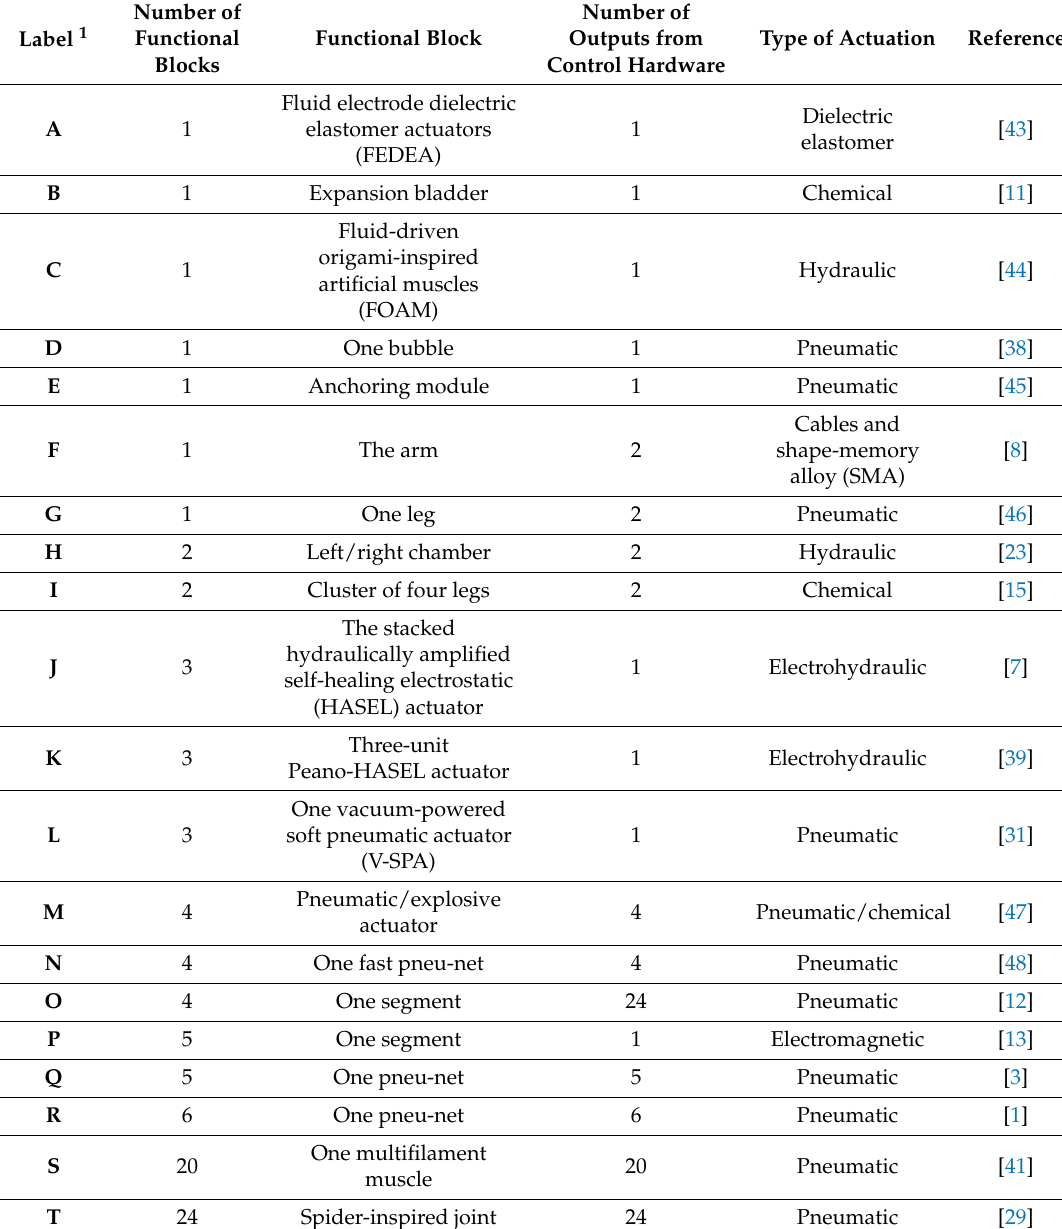
1 The lettering on the left of the table cross-references Figures 1 and